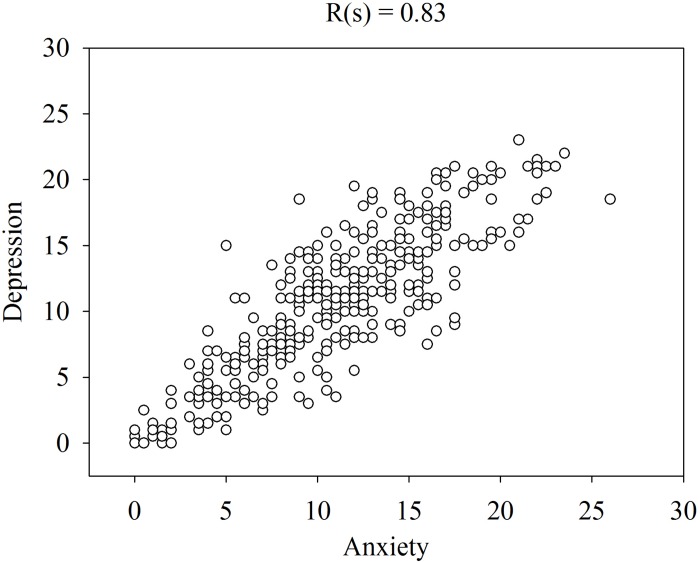
Spearman rank correlation [R(s)] among depression and anxiety in 358 patients with anorexia nervosa determined with the CPRS.